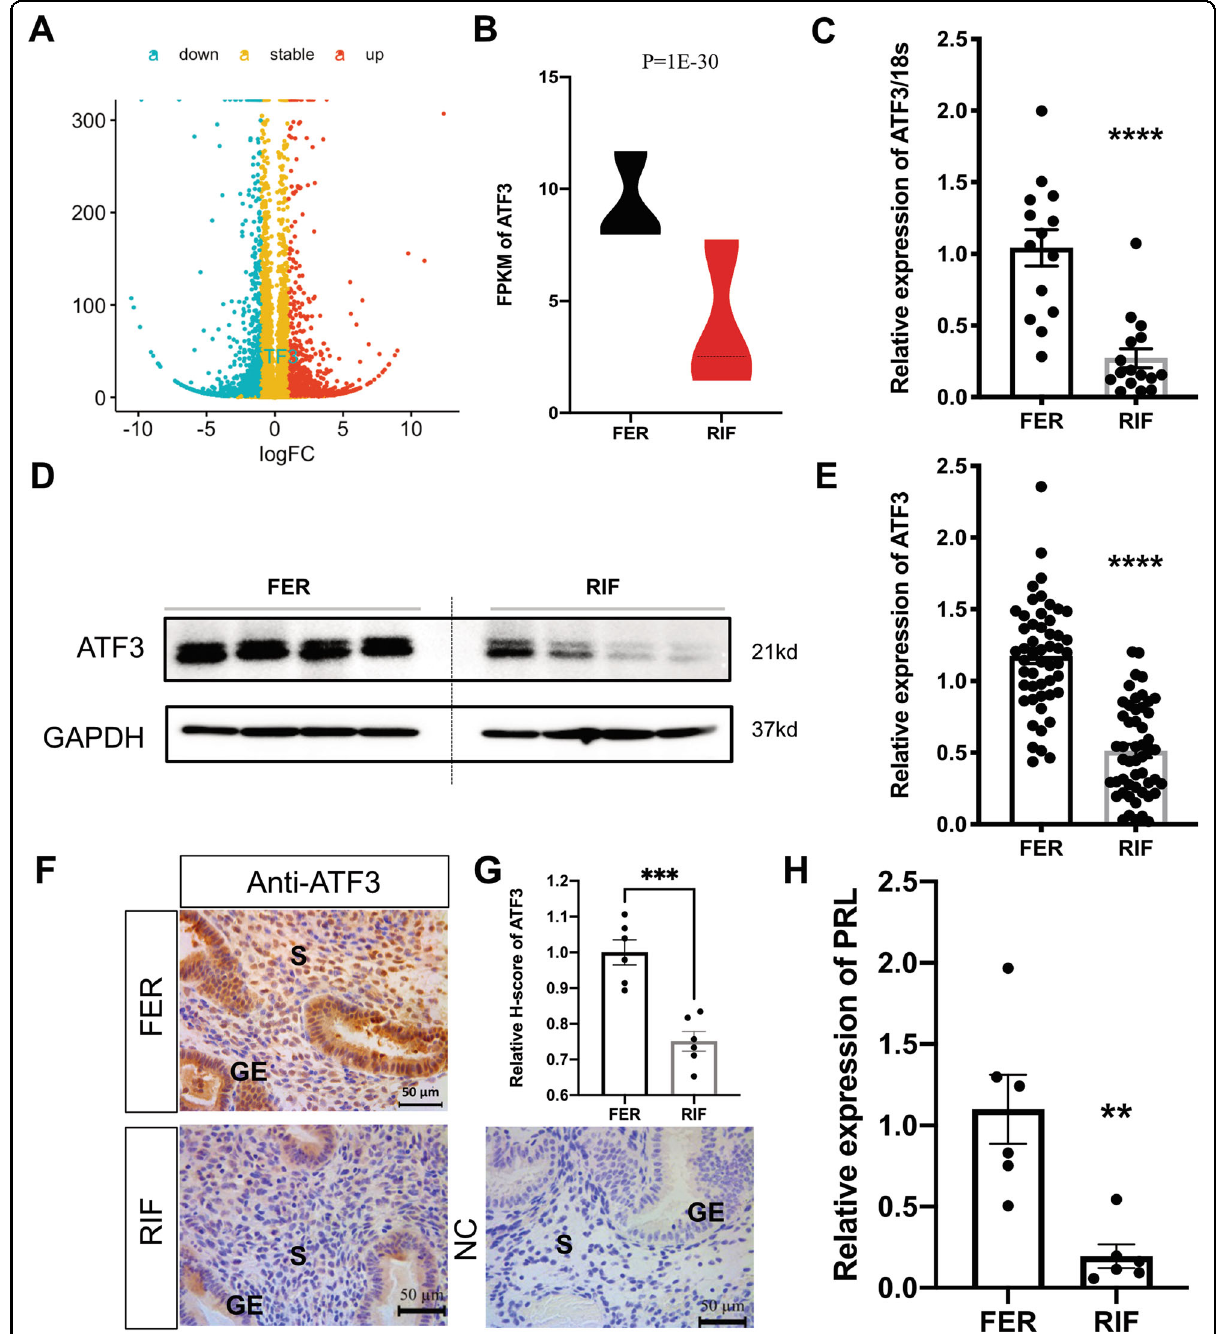
Fig. 1 Aberrant expression of ATF3 in the endometrium of RIF patients. A , B RNA-seq results showed that ATF3 in the endometrium of RIF patients was downregulated (RIF) compared with that in fertile controls (FER). C ATF3 expression in RIF and FER endometrium was measured by quantitative PCR (qPCR). The expression of ATF3 was normalized to 18S rRNA expression, and the results are presented relative to FER stage ( n = 14 for FER group and n = 16 for RIF group). **** P < 0.0001 compared with the FER group. D , E Immunoblotting for ATF3 in the endometrium of RIF patients and the FER group. Quantitative densitometry analysis indicated that ATF3 levels were downregulated in RIF patients (n = 51). **** P < 0.0001 compared with the FER group. F , G Representative immunohistochemical images depicting the expression of ATF3 in the endometrium from fertile women and RIF patients. The negative control (NC) was nonspeci fi c rabbit serum. The H -score of ATF3 expression in the endometrial stromal cells was calculated with IHC-Pro fi ler and ImageJ (scale bar = 50 µm, n = 6, *** P < 0.001). H qPCR was performed to detect the expression of PRL in the endometrium of RIF patients, normalized to 18S rRNA expression ( n =